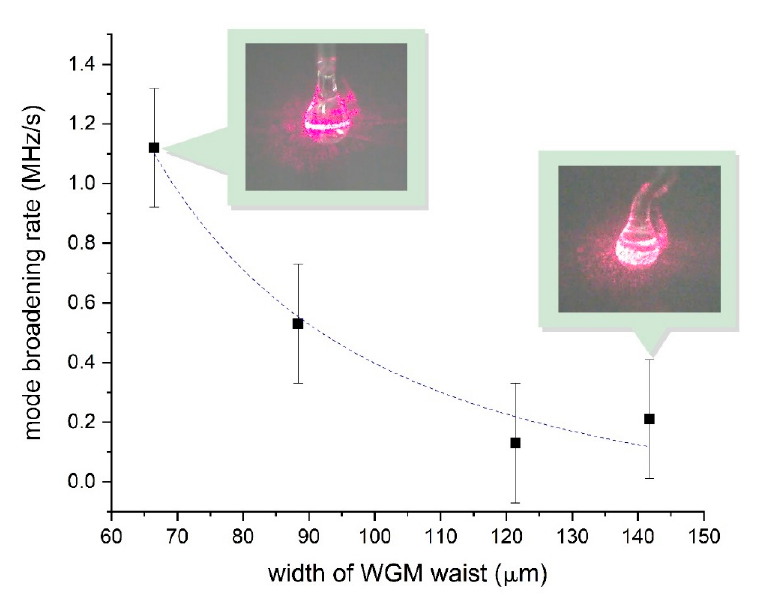
Figure 6. The dependence of the measurement system sensitivity on the width of the WGM belt. The dashed line shows an inverse-square fit. The insets show microcavities with excited WGMs and adsorbed particles with different active interaction areas.